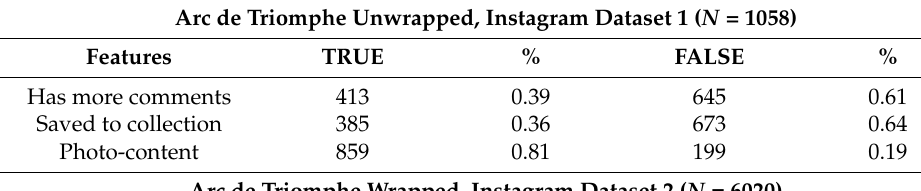
Table 2. Description of the binary values of the Instagram